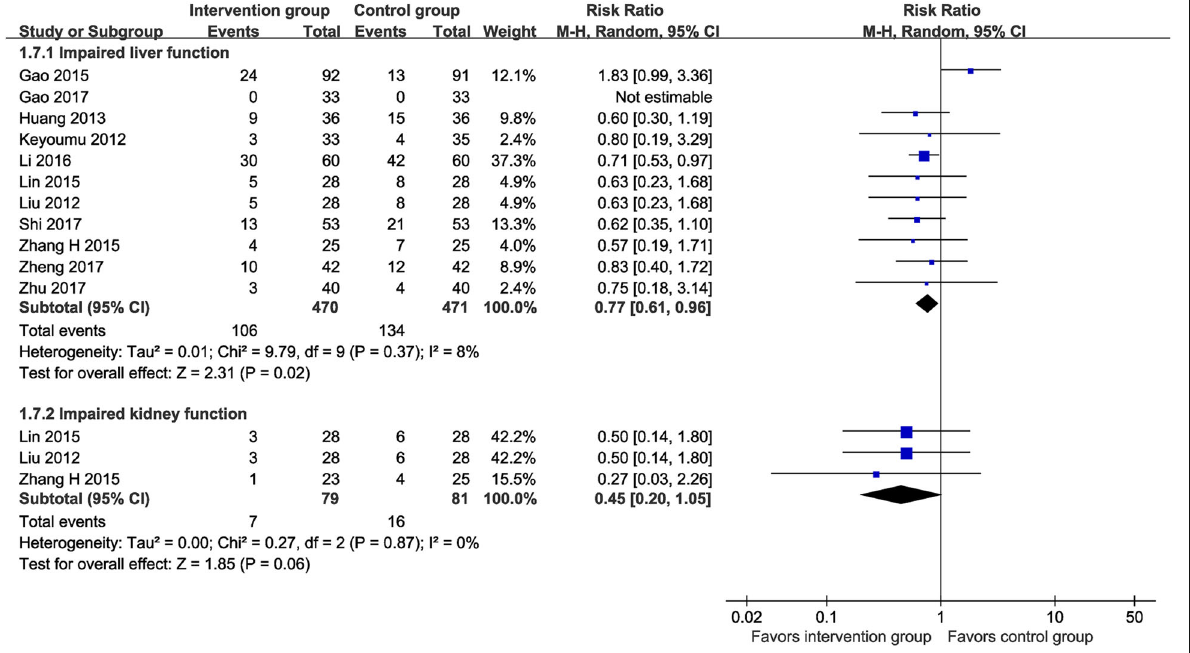
Fig. 9 Meta-analysis on incidence of hepatic and kidney injury